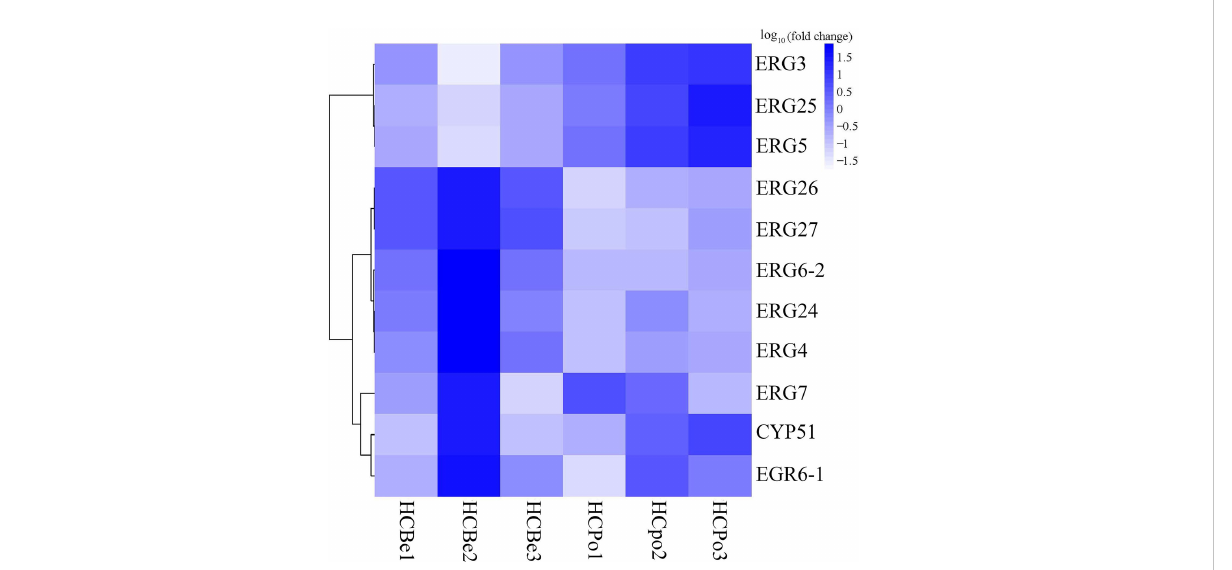
FIGURE 6 The heat map of expression levels of genes associated with ergosterol biosynthesis in Sarocladium terricola . ERG3 (S7G08143, delta7-sterol 5- desaturase), ERG25 (S5G06091, methylsterol monooxygenase), ERG5 (S5G06474, sterol 22-desaturase), ERG26 (S2G02191, sterol-4alpha- carboxylate 3-dehydrogenase), ERG27 (S7G08361, 3-keto steroid reductase), ERG6-2 (S1G00302, sterol 24-C-methyltransferase), ERG24 (S3G03213, delta14-sterol reductase), ERG4 (S1G00326, delta24 (24(1))-sterol reductase), ERG7 (S2G02520, lanosterol synthase), CYP51 (S1G01142, sterol 14alpha-demethylase), and ERG6-1 (S10G10199, delta24(24(1))-sterol reductase). Fold change refers to expression levels in potato dextrose media as compared to bean